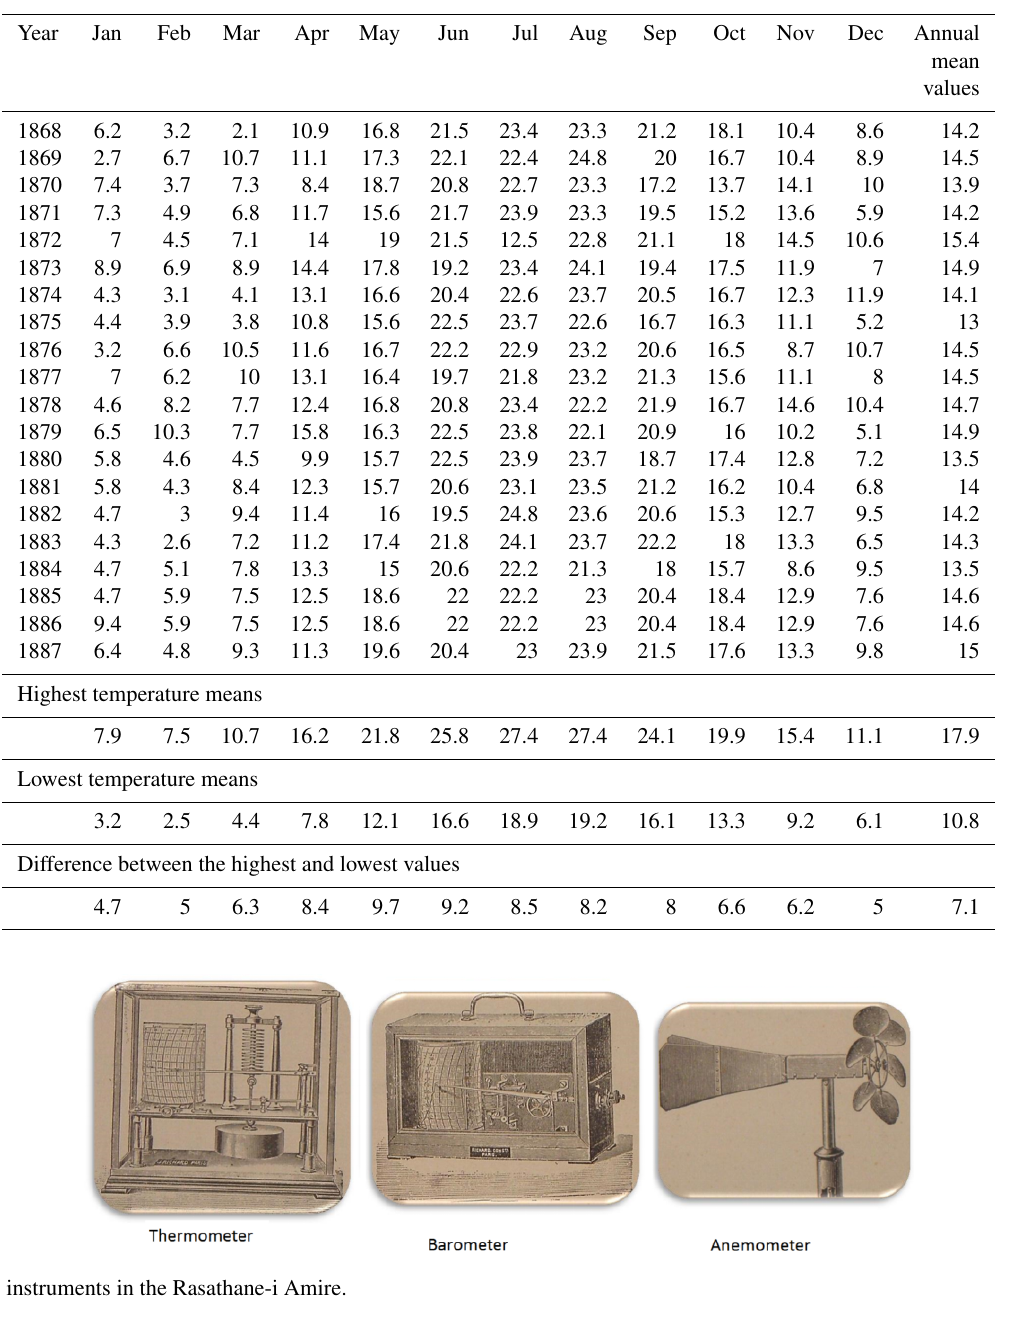
Table 1. Monthly and annual temperature values between 1868 and 1887 (Fettahoglu, 2002). Year